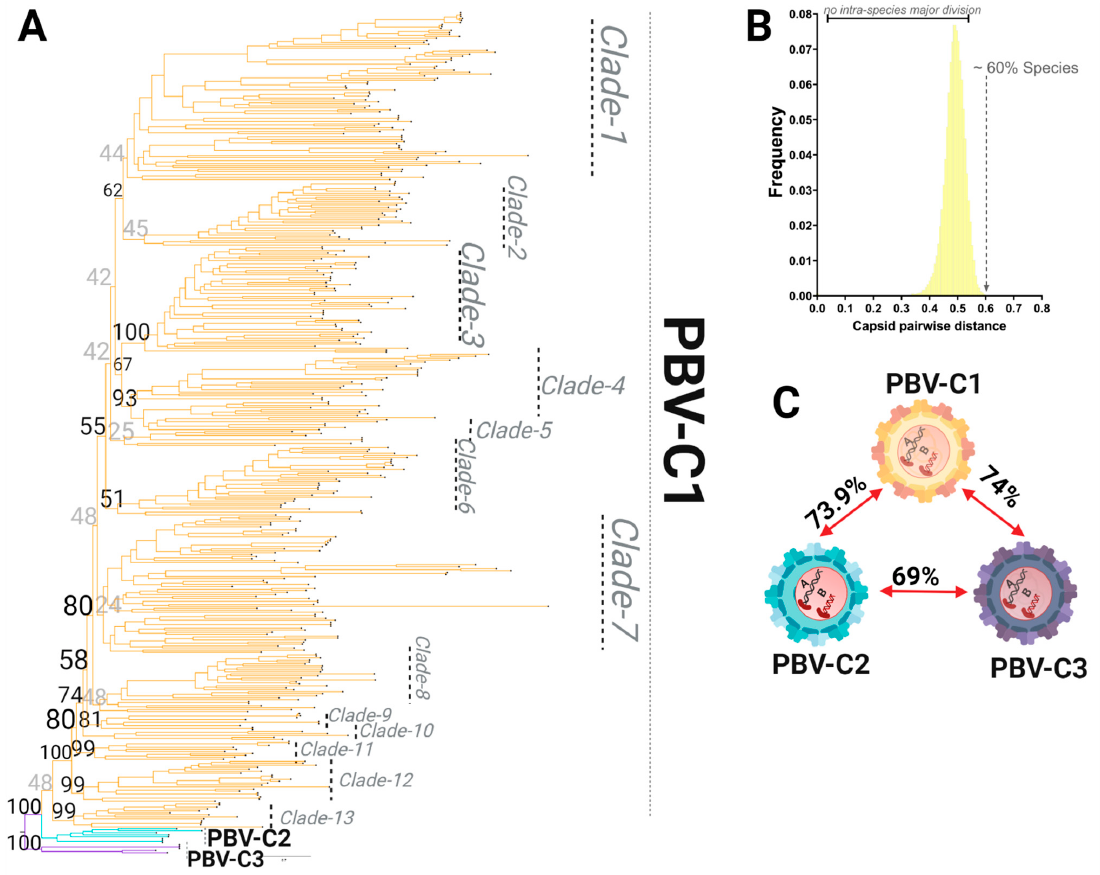
Figure 6. Species demarcation and intraspecies diversity of the picobirnavirus based on the capsid coding region. ( A ) Phylogenetic tree based on the complete coding sequence of capsid using all 422 non-redundant genomes available in GenBank using the maximum likelihood (ML) method with the LG + F + R10 model. ( B ) PASC results for the frequency distribution of pairwise distances for all 422 capsid sequences. The lack of a major division(s) indicates no relevant subclassification of sequences is present. The cut-off value for species demarcation at >60% genetic distance is indicated. ( C ) Genetic distances for the three main lineages are shown. All have >60% genetic distance and thus are considered species, with further internal divisions designated as clades when statistical support for the node and the number of taxa (>3) allowed this classification (see 6A for PBV-C1).